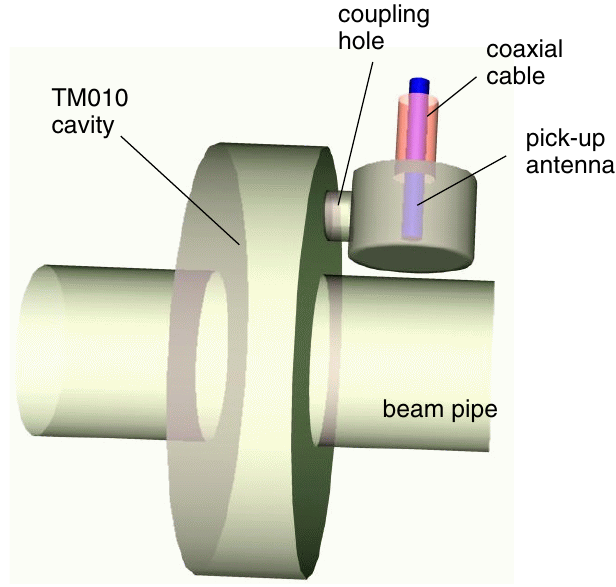
FIG. 4. (Color) Structure of the reference cavity.